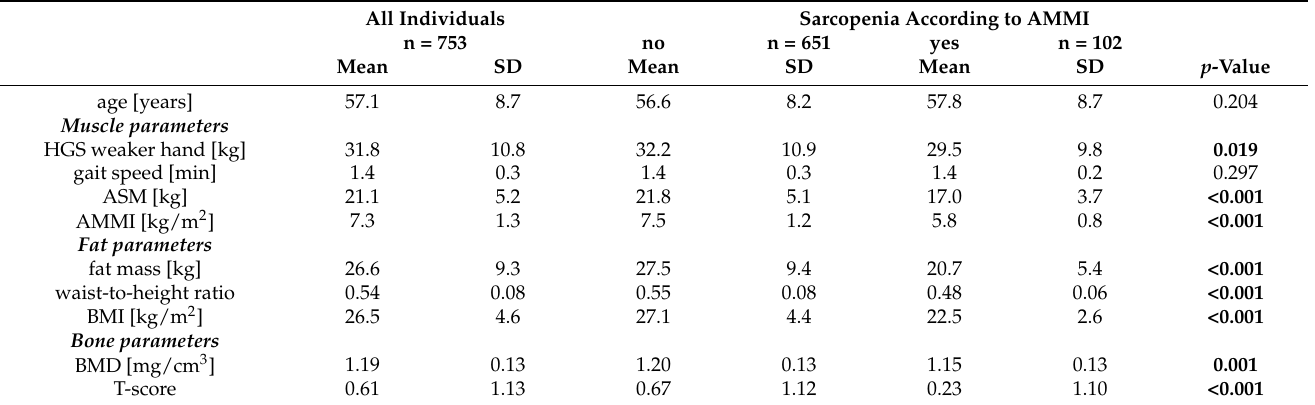
Table 2. Sarcopenia-related parameters in all persons and persons with and without sarcopenia according to